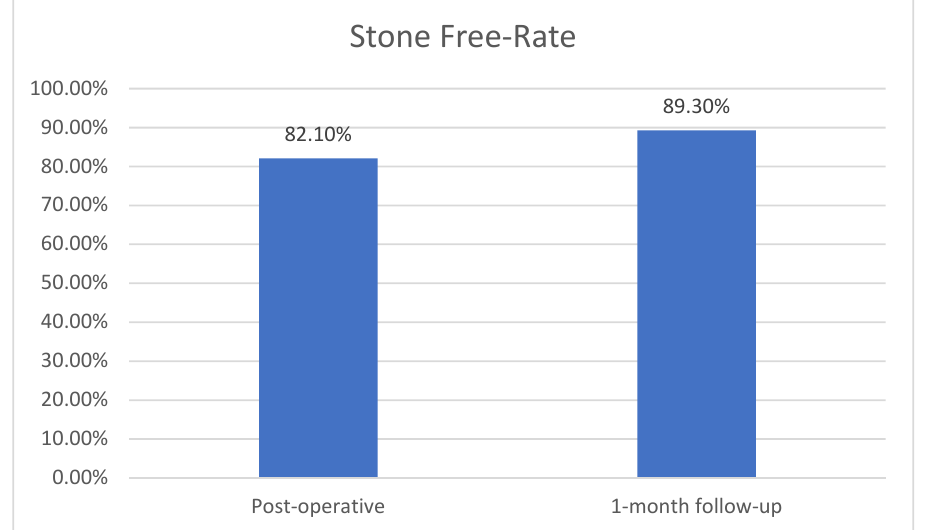
Figure 4. Overall stone-free rate in the Trilogy group. Table 3. Comparison of main surgical parameters between the two groups.